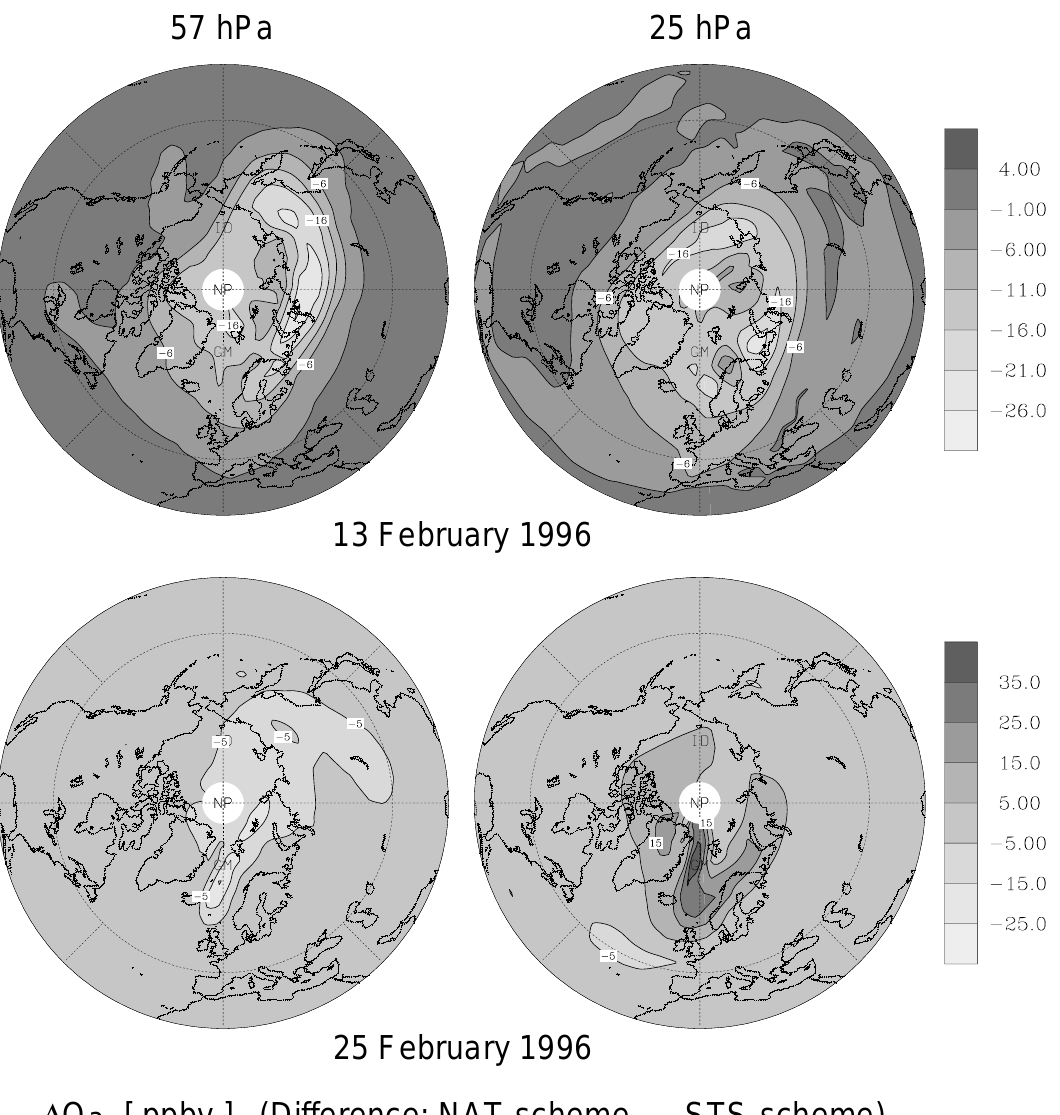
Fig. 10. Difference in the ozone mixing ratio (ppbv) occurring between the simulations performed with the NAT- and the STS-scheme on (left) the 57 hPa and (right) the 25 hPa level. Results are presented obtained for (top panels) 13 February 1996, and (bottom panels) 25 February